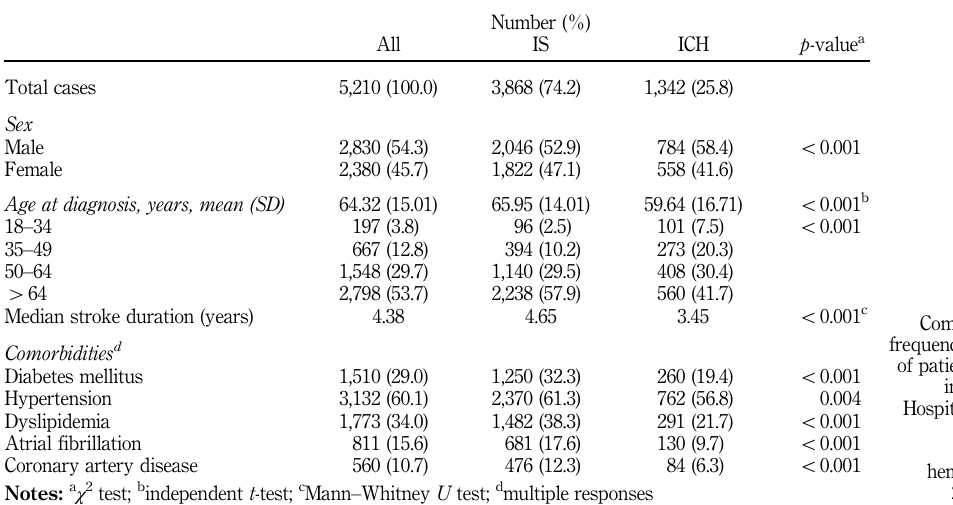
Table I. Comparison of the frequency distribution of patients